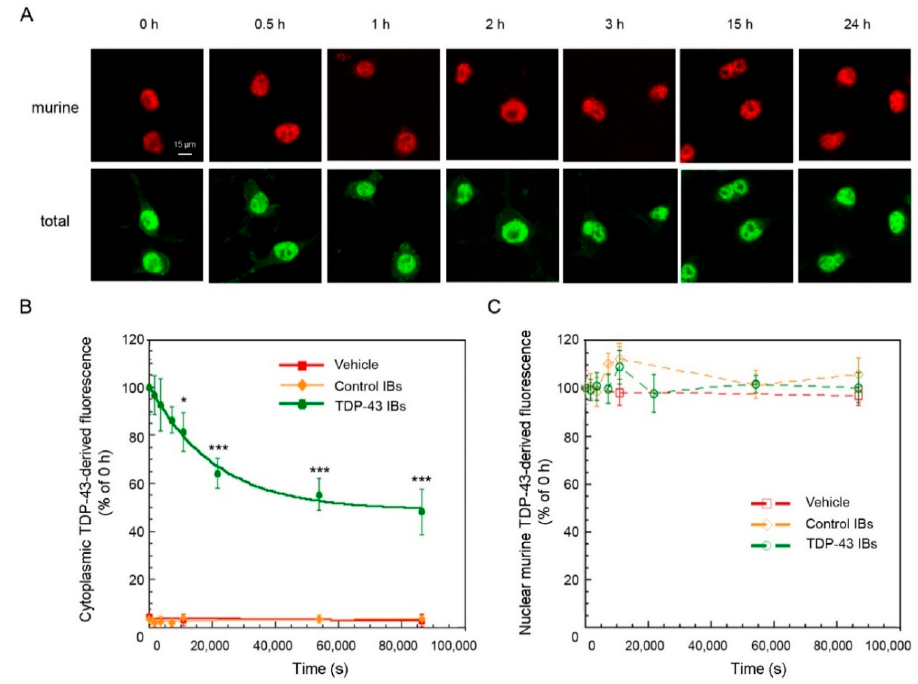
Figure 4. TDP-43 clearance in N2A following the transfection with TDP-43 aggregates. ( A ) Representative confocal scanning microscope images of N2A cells that were transfected with TDP-43 IBs and analyzed at the indicated time points after transfection. Red and green fluorescence indicates endogenous murine TDP-43 and total TDP-43 (human and murine) detected with immunofluorescence. ( B , C ) Kinetic plots showing cytoplasmic ( B ) and nuclear ( C ) TDP-43 derived fluorescence, detected with Abs against total ( B ) and only murine ( C ) TDP-43 as a function of time after transfection of N2A cells with vehicle (red), control IBs (yellow), and TDP-43 IBs (green). The line in panel ( B ) represents the best fits to an exponential function. Error bars: S.D. * p < 0.05 and *** p < 0.001 relative to cells analyzed 0 h after transfection.